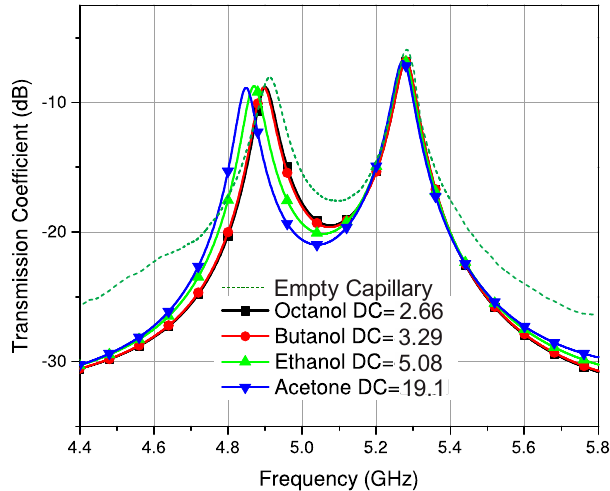
Figure 6. Response of filter with the vertical orientation of the LUT.